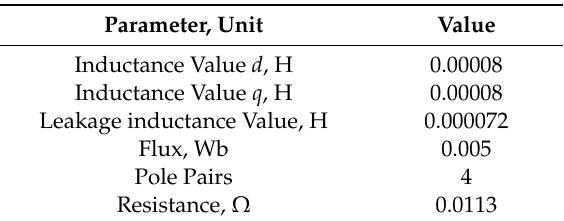
Table 1. Machine parameters.